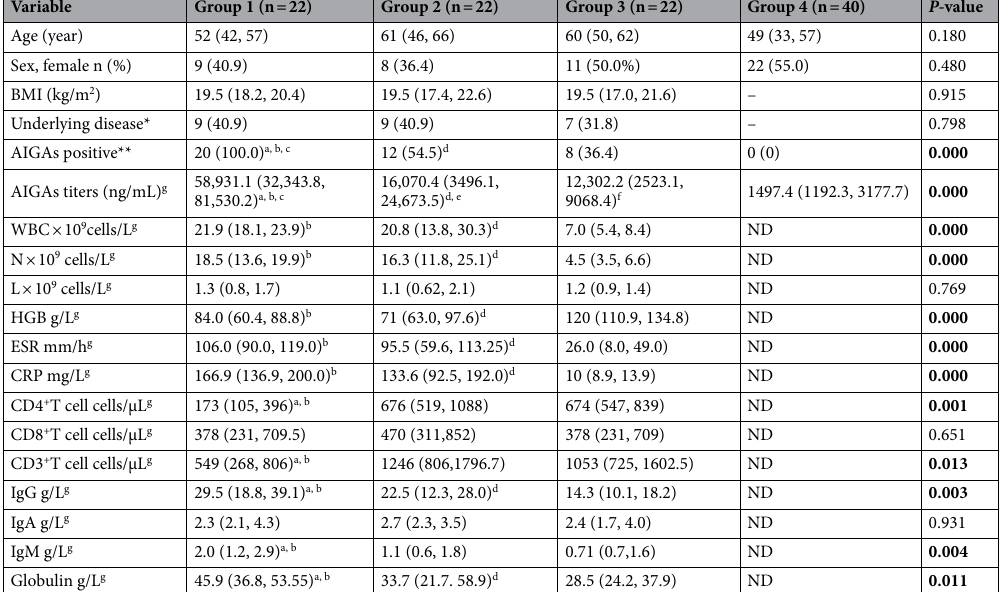
Table 1. Baseline demographics and clinical characteristics of the 106 participants. Bold values indicate significant difference between groups or in univariate logistic regression analysis. a Indicates statistical significance between Groups 1 and 2. b Indicates statistical significance between Groups 1 and 3. c Indicates statistical significance between Groups 1 and 4. d Indicates statistical significance between Groups 2 and 3. e Indicates statistical significance between Groups 2 and 4. f Indicates statistical significance between Groups 3 and 4. g A total number of 14 patients in Group 1 had AIGAs titer, WBC, N, L, HGB, ESR, CRP, globulin, immunoglobulins (IgG, IgA, IgM), and lymphocytes subpopulations (CD4 + T cell, CD8 + T cell, CD3 + T cell) data. Data are expressed as median ± interquartile range. Kruskal–Wallis H test was used to determine statistical significance among the 3 or 4 groups, followed by a 2 by 2 comparison across groups through a Fisher’s exact test. P < 0.05 indicates statistical significance. Group 1 = patients with TM and NTM co-infections; Group 2 = patients with TM mono-infection; Group 3 = patients with NTM mono-infection; Group 4 = healthy control volunteers. *Indicates the nature of the underlying disease in three groups. Group 1: 5 cases with Sweet’s syndrome, 1 case with malignant tumor, 1 case with cystic fibrosis, 1 case with Behcet’s syndrome, and 1 case with diabetes; Group 2: 1 case with thalassemia, 1 case with Sjogren’s syndrome, 1 case with ankylosing spondylitis, 1 case with major trauma or surgery, 1 case with hyperthyroidism, 2 cases with glucocorticoids and or immunosuppressive agents, 1 case with hypertension, and 1 case of diabetes. Group 3: 3 cases with major trauma or surgery, 3 cases with hypertension, and 1 case with diabetes. **Serums from 14 participants in Group 1, all patients in Groups 2 and 3, and 40 health volunteers were tested for anti-IFN-γ autoantibodies. Six of eight patients in the literature review cohort in Group 1 were defined as AIGA-positive, while the last 2 patients were not assessed. Thus, a total of 20 patients were tested for AIGAs in Group 1. BMI body mass index, AIGAs anti-IFN-γ auto-antibodies, ND no data, WBC white blood cell, N neutrophil counts, L lymphocyte counts, HGB haemoglobin, ESR erythrocyte sedimentation rate, CRP C-reactive protein, Ig immunoglobulin. Normal range: IgG, 8–18 g/L; IgA, 2.01–2.69 g/L; IgM, 0.84–1.32 g/L; CD4 + T cell,